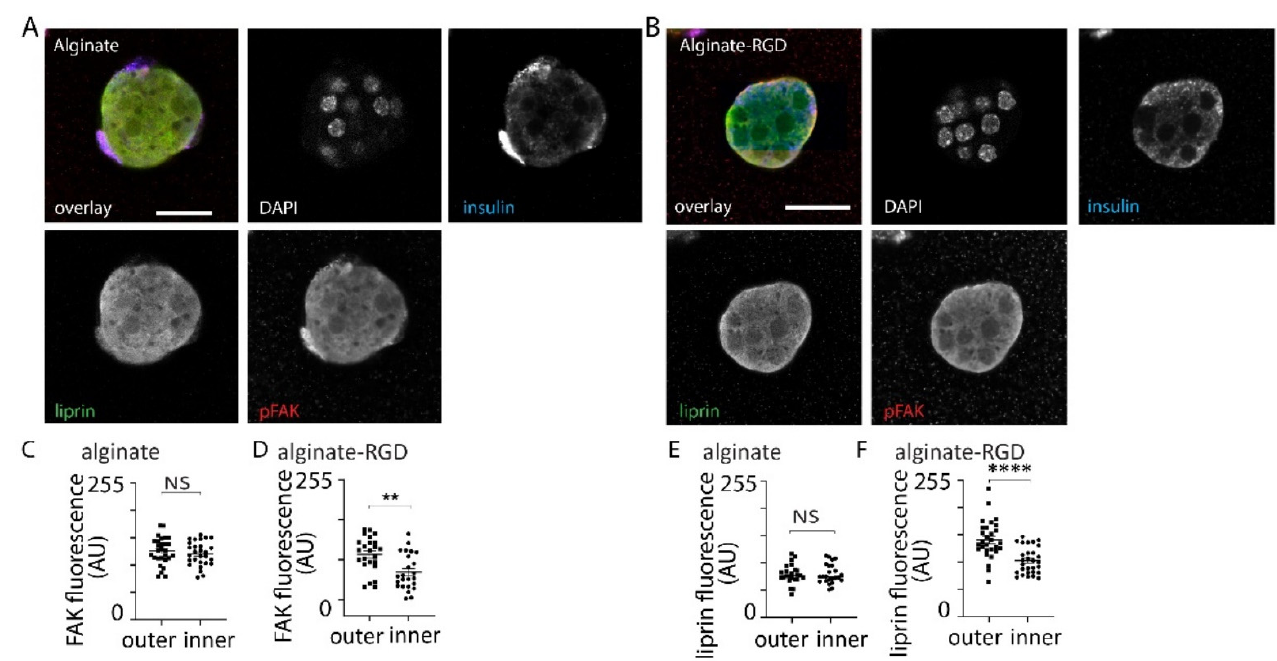
Figure 4. Immunostaining showed activation of focal adhesion kinase, measured with a phospho- specific antibody, in response to the RGD domain. ( A , B ) Example images from spheroids within alginate alone or alginate-RGD showed the distribution of liprin and phospho-FAK. ( C , D ) Image analysis comparing the fluorescence intensity of pFAK staining at the outer membranes with staining on the inner membrane demonstrating no difference in spheroids embedded in alginate (n = 28 cells, Student t test p = 0.41) but a significant difference in alginate-RGD (n = 24 cells, Student t test p < 0.01, ** p < 0.01 ). ( E , F ) Image analysis comparing the fluorescence intensity of liprin staining at the outer membranes with staining on the inner membrane demonstrating no difference in spheroids embedded in alginate (n = 24 cells, Student t test p = 0.92) but a significant difference in alginate-RGD (n = 29 cells, Student t test p < 0.001, **** p < 0.001). Scale bars 20 µm.